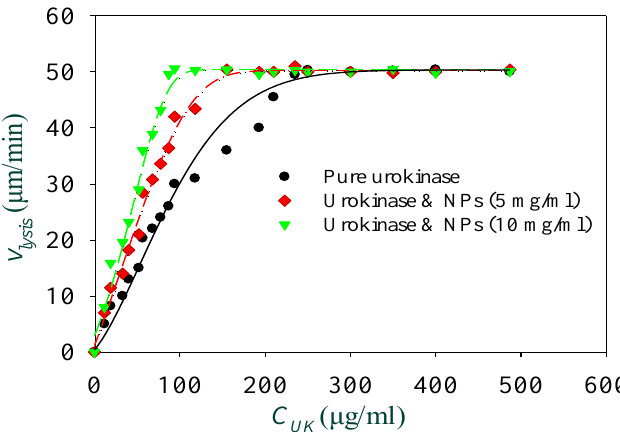
Figure 7. The thrombus lysis speed varies with the concentration of urokinase.